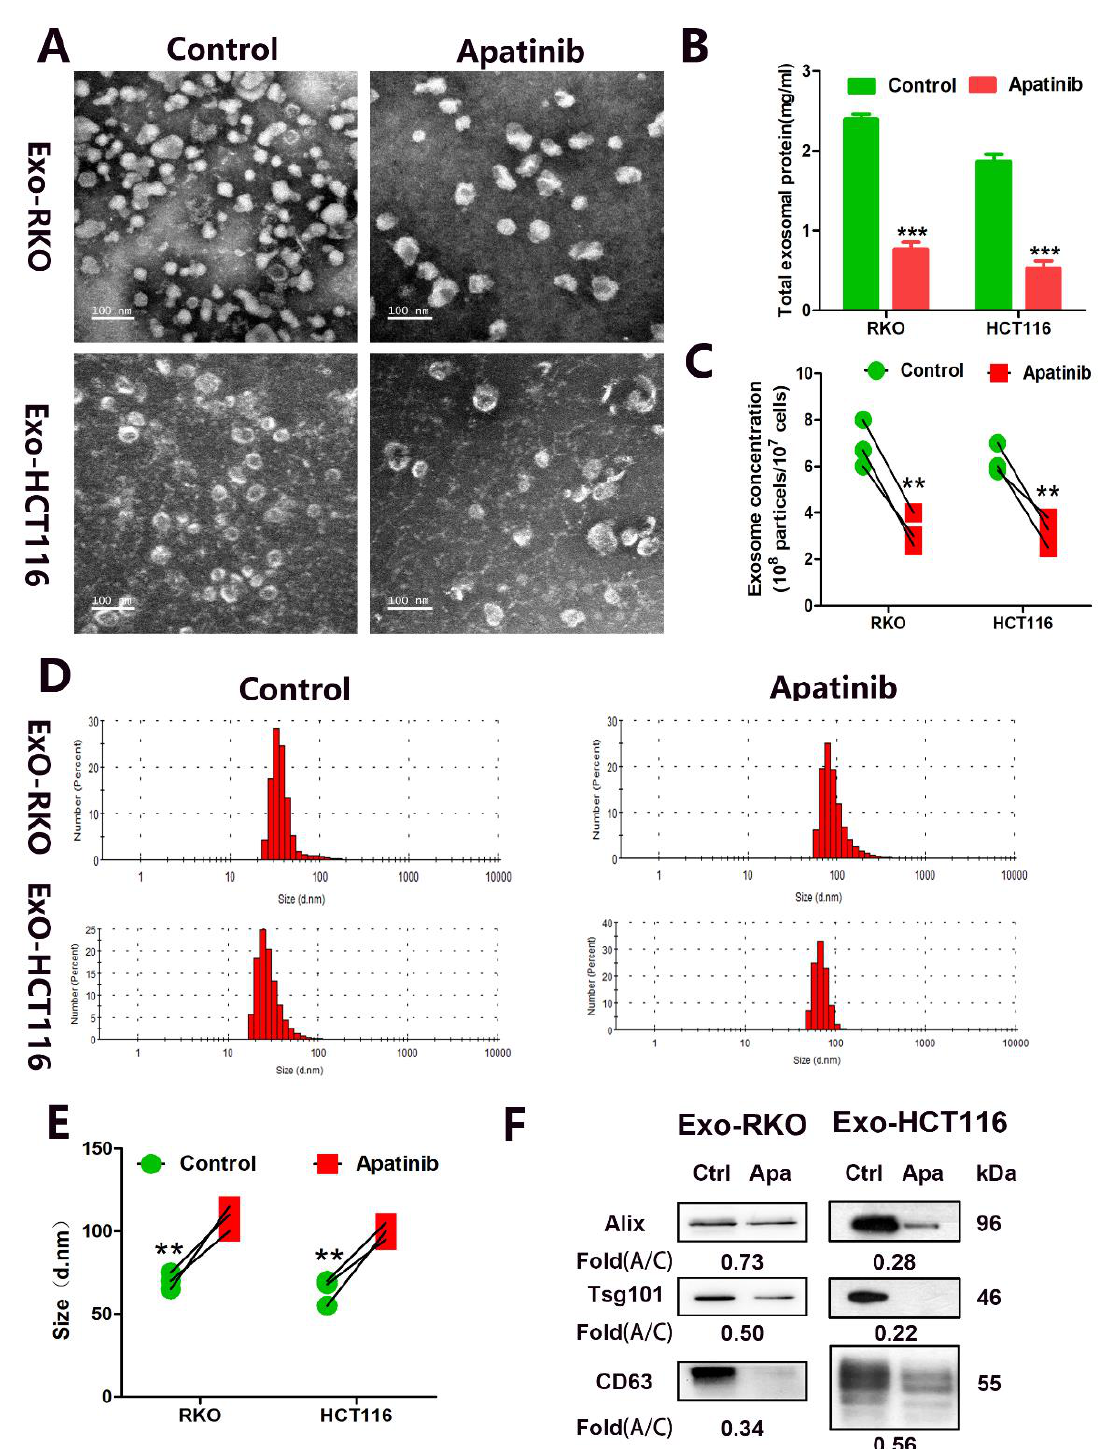
Figure 4. Apatinib inhibited exosome secretion in CRC cells in vitro. ( A ) Isolated exosomes from RKO and HCT116 cells were assessed by transmission electron microscopy. ( B ) Quantification of the exosomal protein levels obtained from control and apatinib treatment cells. ( C – E ) NTA and NTA analysis of the effect of apatinib on exosome release in RKO and HCT116 cells. ( F ) Western blot analysis of exosome purified from equal numbers of the control and apatinib treatment cells. Data are reported as the mean ± standard error (SD) from three independent experiments, t -test, ** p < 0.01, and *** p < 0.001.